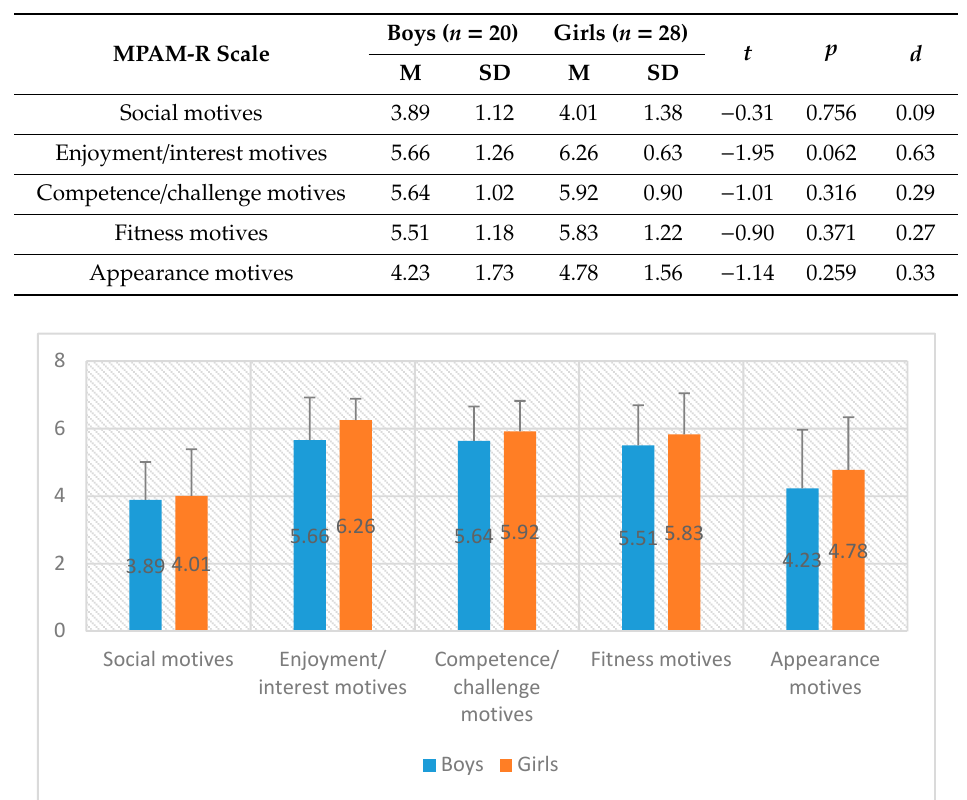
Table 3. Di ff erences in motivation depending on gender. SD: standard deviation.